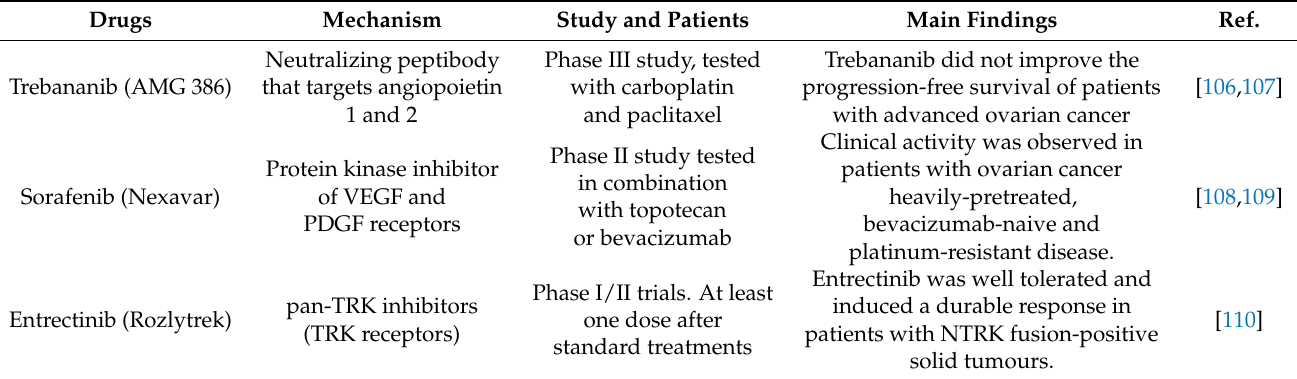
Table 2. Summary of several new anti-angiogenic options under study in